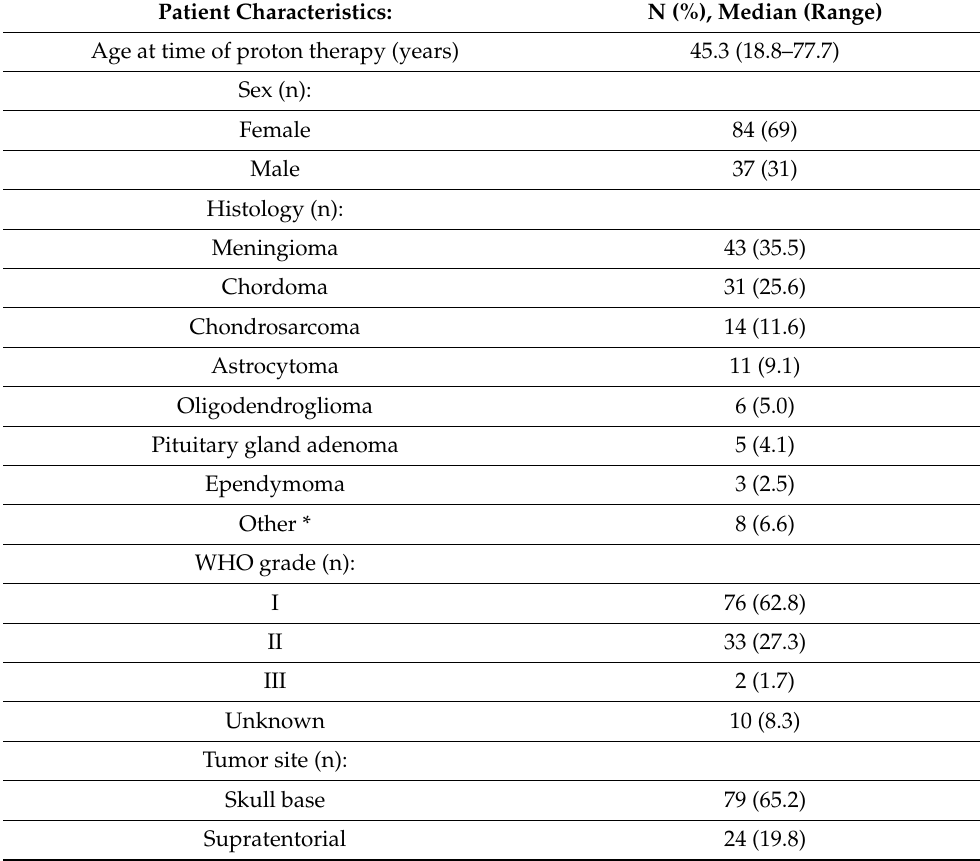
Table 1. Patient and treatment characteristics. Patient